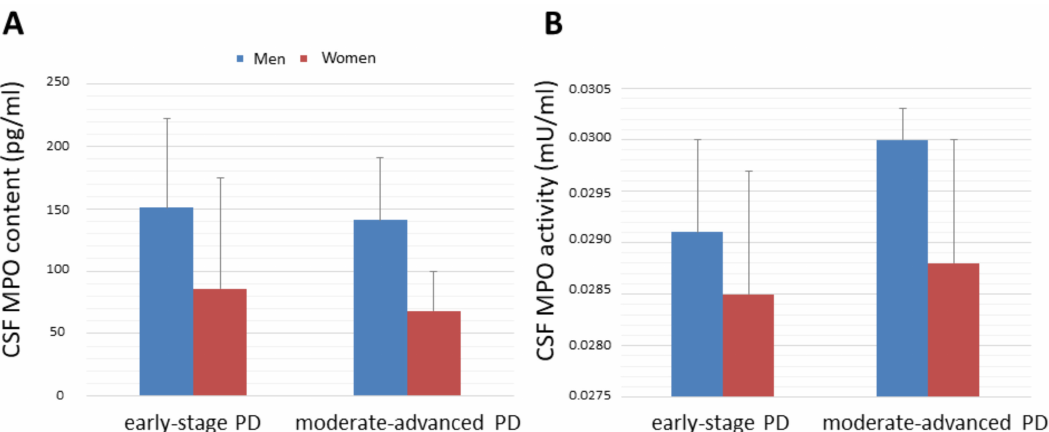
Figure 3. ( A ) MPO concentration (pg/mL) and ( B ) MPO activity (mU/mL) in the CSF in male patients and female ones at early-stage disease (Hoehn and Yahr stages 1 and 2) and patients with moderate-advanced disease (Hoehn and Yahr stages 2.5–4). No significant differences were found. Mean ± standard deviation. Abbrev.: CSF, cerebrospinal fluid; MPO, myeloperoxidase; PD, Parkinson’s